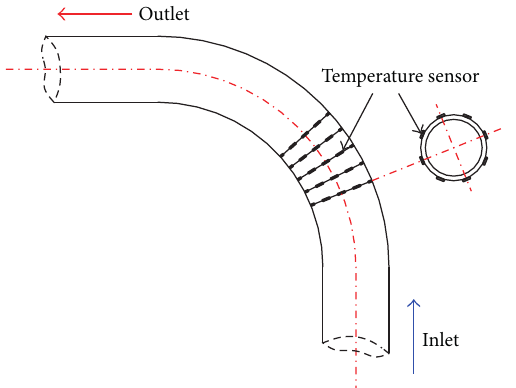
Figure 9: Schematic diagram of the temperature monitoring ar- rangement.